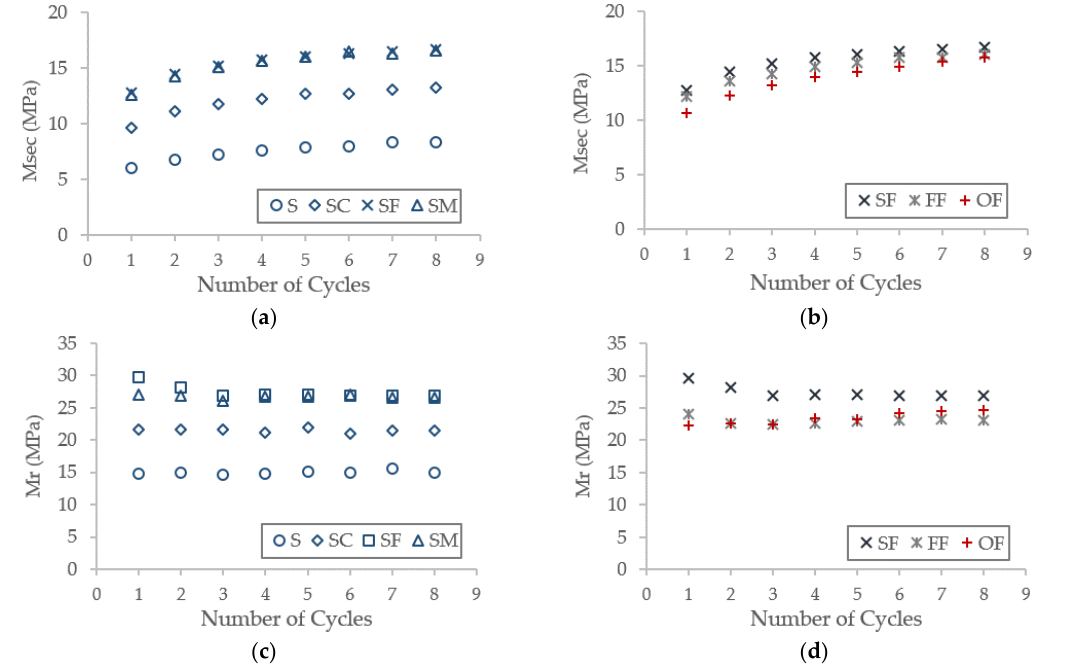
Figure 3. In each consecutive cycle: ( a ) Secant Modulus for the S carpet with alternating types of ceramic sand; ( b ) Secant Modulus for the F ceramic sand with different carpets; ( c ) Resilient Modulus for S carpet and varying types of ceramic sand; ( d ) Resilient Modulus for the F ceramic sand and diverse